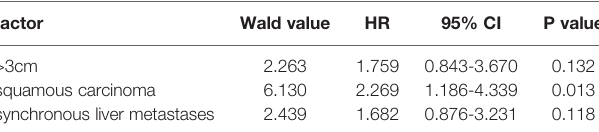
TABLE 2 | Multivariable analysis of liver metastasis of lung cancer on overall survival. factor Wald value HR 95%